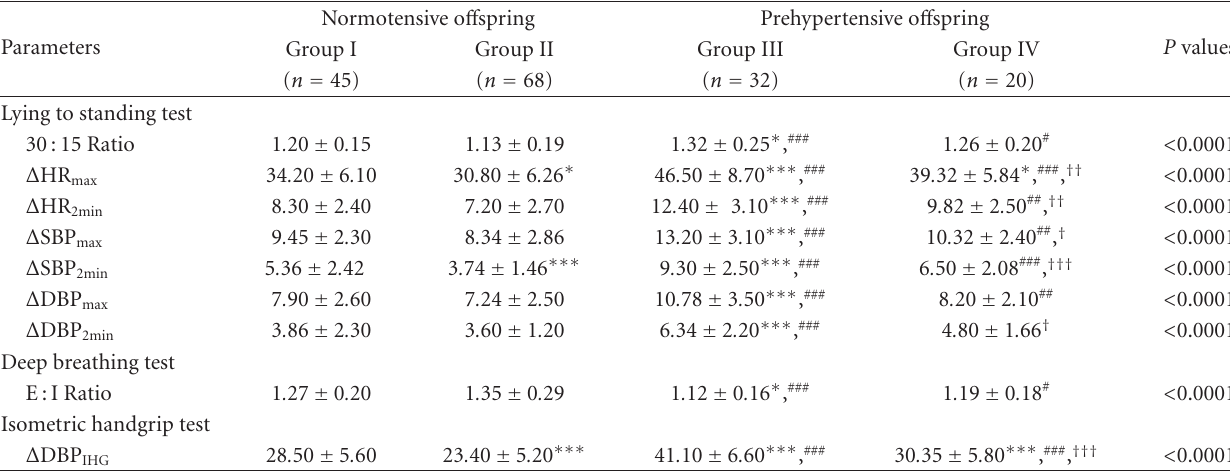
Table 4: Parameters of lying to standing test, deep breathing test, and isometric handgrip test of normotensive and prehypertensive o ff spring of hypertensive parents.